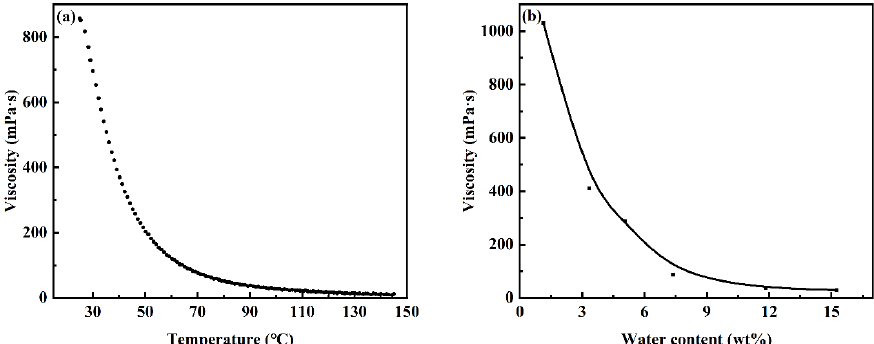
Figure 7. The influence of temperature ( a ) and water content ( b ) on the viscosity of [Hbet][Tf 2 N]. The alkali decomposition products could not be completely dissolved in the [Hbet][Tf 2 N]–H 2 O system. The leaching residues were further analyzed to determine the composition and morphology of the insoluble residues. SEM-EDS results of the leaching residues showed that (Figure 8a – c) the particles of the insoluble residues showed the microstructure of corrosion, which is completely dif- ferent from the bastnaesite and alkali decomposition products. The XRD and EDS results indicated that the residues were mainly undecomposed bastnaesite. FTIR curves (Figure 8e) of bastnaesite, alkali hydrolysis products of bastnaesite, and leaching residue showed that the absorption peaks of the leaching residues and bastnaes- ite were basically the same at 1086 cm −1 , 870 cm −1 , 1456 cm −1 , and 727 cm −1 , which correlate to the symmetric stretching vibration peak, out-of-plane bending vibration peak, asym- metric stretching vibration peak, and in-plane bending vibration peak of CO 3 2− , respec- tively. The absorption peaks at 3606 cm −1 and 1644 cm −1 of the bastnaesite alkaline hydrol- ysis products were -OH stretching vibration peaks. It had an absorption peak of CO 3 2− at 1456 cm −1 , indicating that there was still a small amount of bastnaesite in the sample that had not been completely hydrolyzed. From the Raman spectra (Figure 8f), the peak positions of bastnaesite at 255 cm −1 , 346 cm −1 , and 393 cm −1 were related to halogen fluorine. Its peak positions at 686 cm −1 and 737 cm −1 were the in-plane bending vibration peaks of CO 3 2− , and the peak position at 868 cm −1 was the out-of-plane bending vibration peak of CO 3 2− . After alkali hydrolysis of bastnaes- ite, the peaks of -OH of rare earth hydroxides were detected at 1608 cm −1 and 3598 cm −1 . After leaching, the hydroxide was dissolved, and the rest was mainly the remaining fluo- rocarbonate due to incomplete alkaline decomposition, so its Raman spectrum was similar to that of bastnaesite. This result indicated that the leaching efficiencies of REEs were ob- viously affected by the alkaline decomposition pretreatment of bastnaesite.